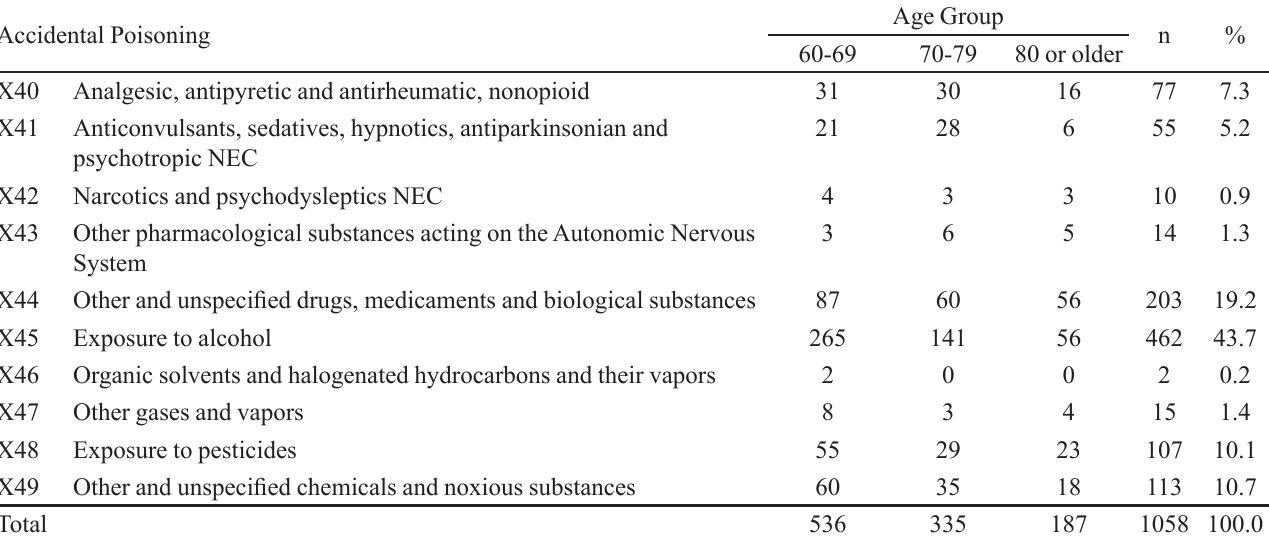
TABLE II - Elderly patients hospitalized for accidental poisoning by age group. Brazil, 2008-2009 Accidental